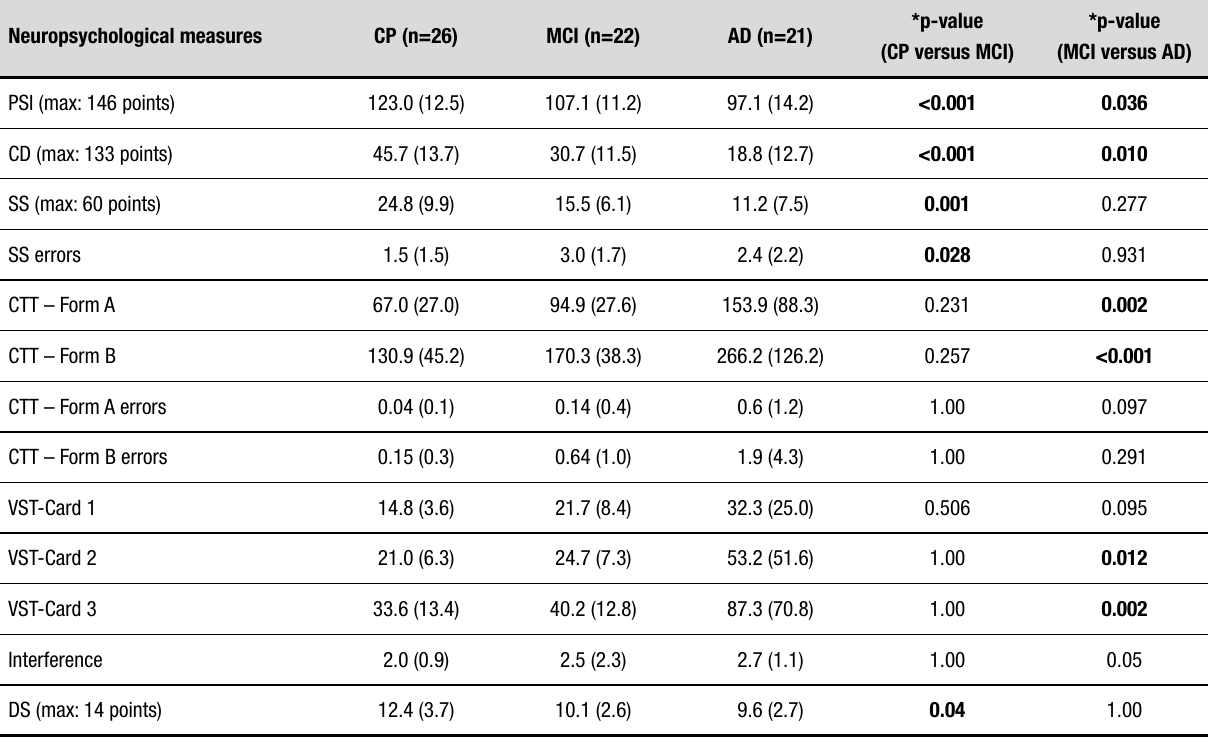
Table 2. Mean and standard deviation of neuropsychological measures and pairwise comparisons.